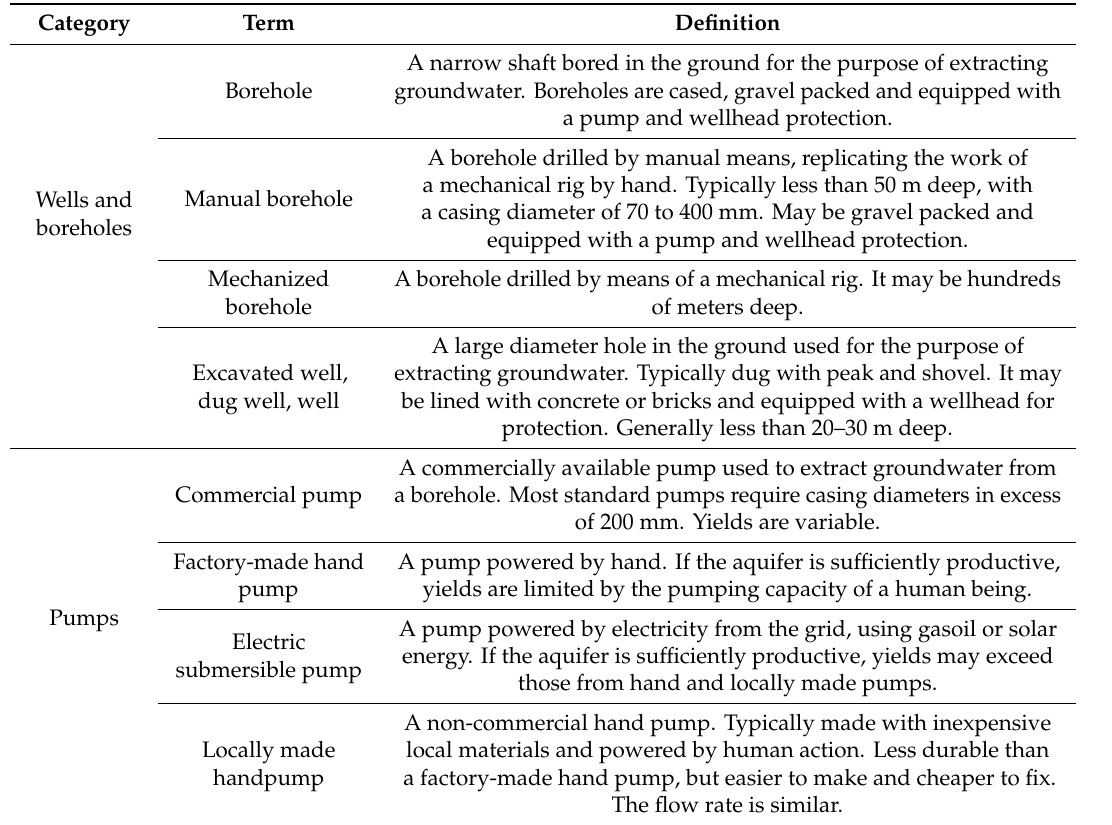
Table 1. Key definitions and concepts